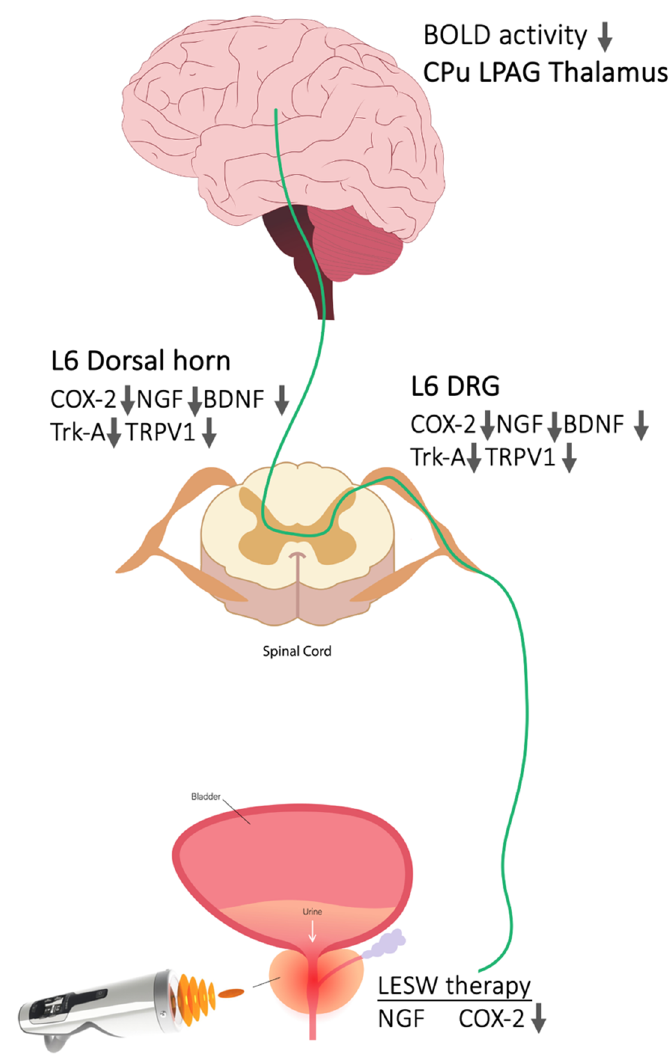
Figure 7. A model illustrating LiESWT treatment on prostate inhibiting the nociceptive molecular and downregulating central sensitization in capsaicin-induced prostatitis in rats. Li-ESWT on prostate decreased the COX-2, NGF expression in the prostate in association with attenuated inflammatory and neurotrophic molecular expression in DRG and its relay neurons at dorsal horn of spinal cord. This anti-nociceptive effect projected through the ascending pathway to the